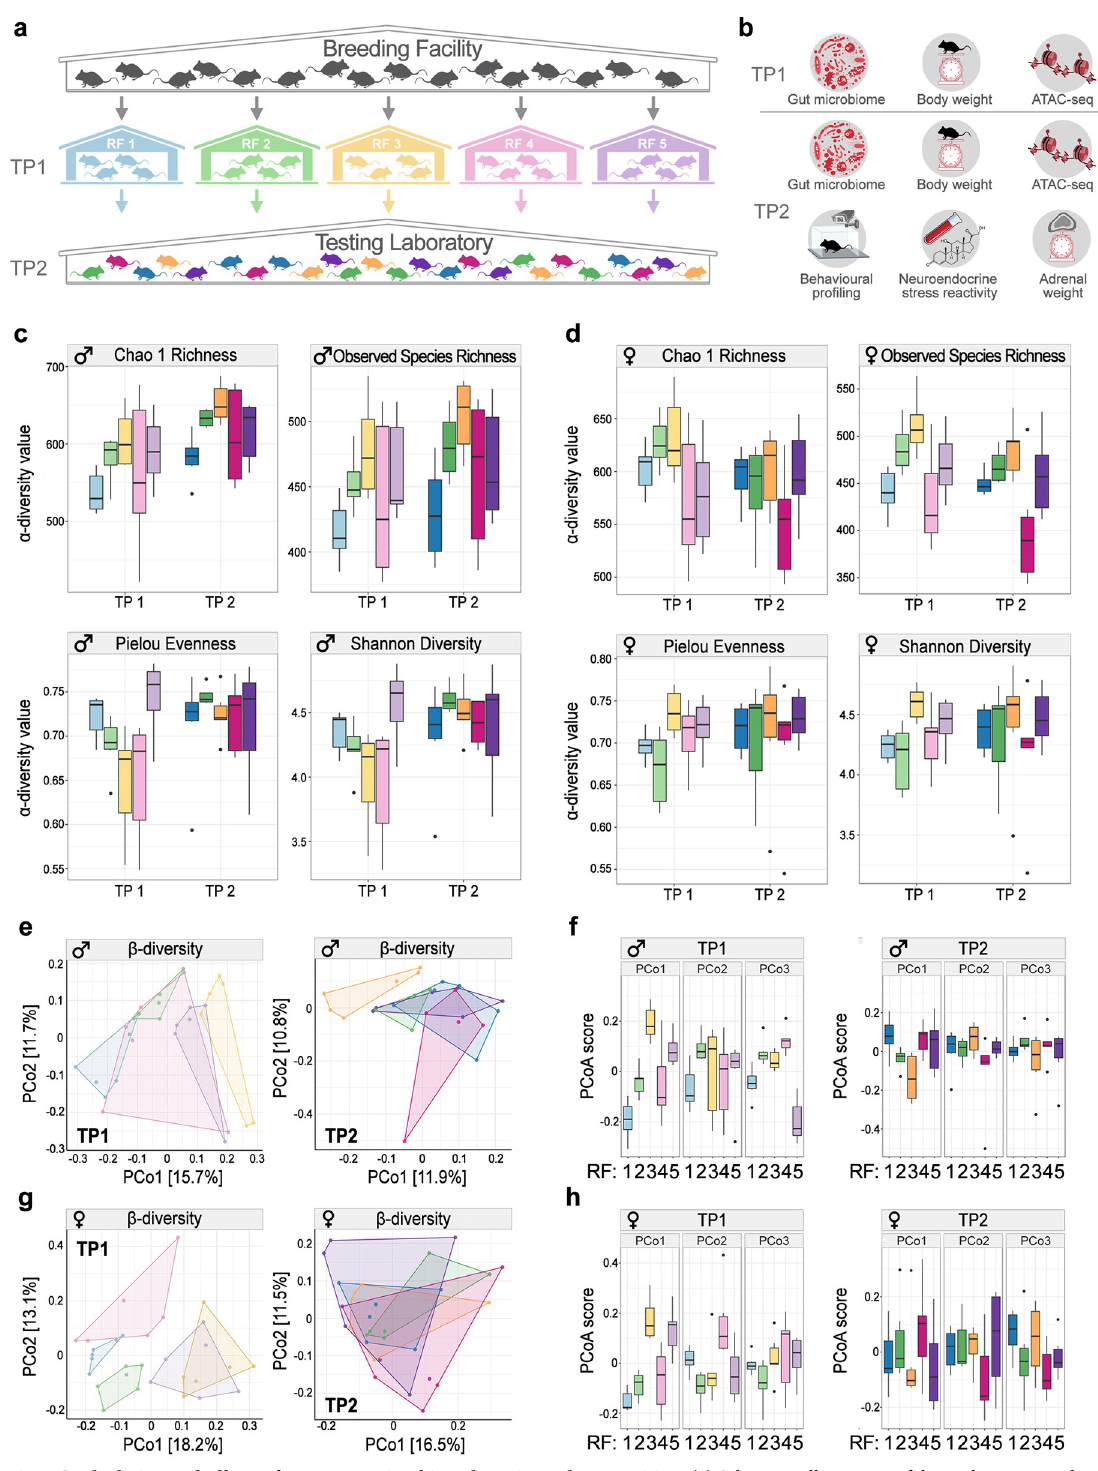
Fig 1. Study design and effects of RF on gut microbiota diversity and composition. (a) Schematic illustration of the multicentre study design—genetically homogeneous mice originating from a single inbred stock were reared until the age of 8 weeks in 5 different RFs before testing for phenotypic differences induced by the different rearing conditions in a single testing laboratory. ( b) Effects of the RF were evaluated at 2 TPs, first, at the end of the rearing period in each of the 5 RFs (TP1) and during the testing period in the testing laboratory (TP2). Outcome measures assessed at both TP1 and TP2 included gut microbiota, body weight, and chromatin profiles using ATAC-seq,